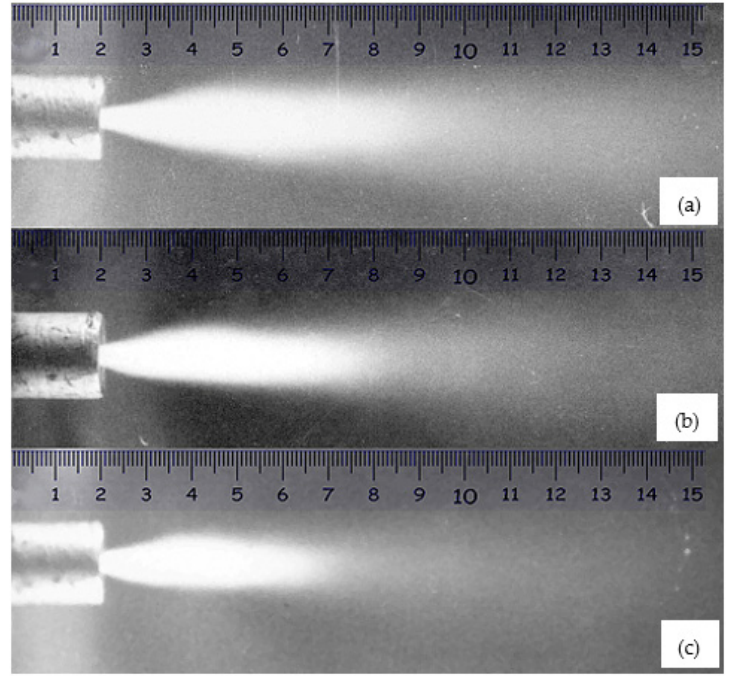
Figure 11. Cavitating jet inside the test chamber. P in = 300 atm: ( a ) P out = 0 (gauge), ( b ) P out = 10 atm (gauge), ( c ) P out = 30 atm (gauge).